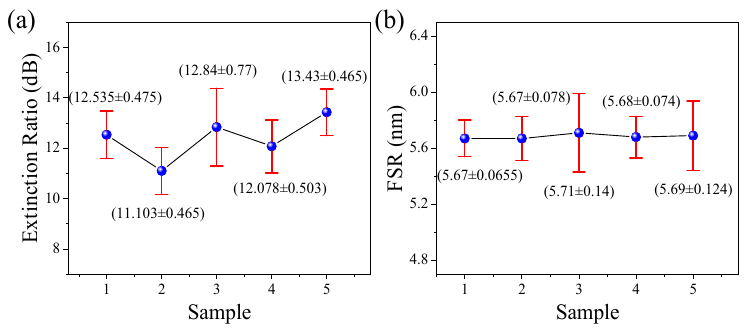
Figure 5. The fabrication repeatability in terms of ( a ) ER and ( b ) spatial frequency of fringes.